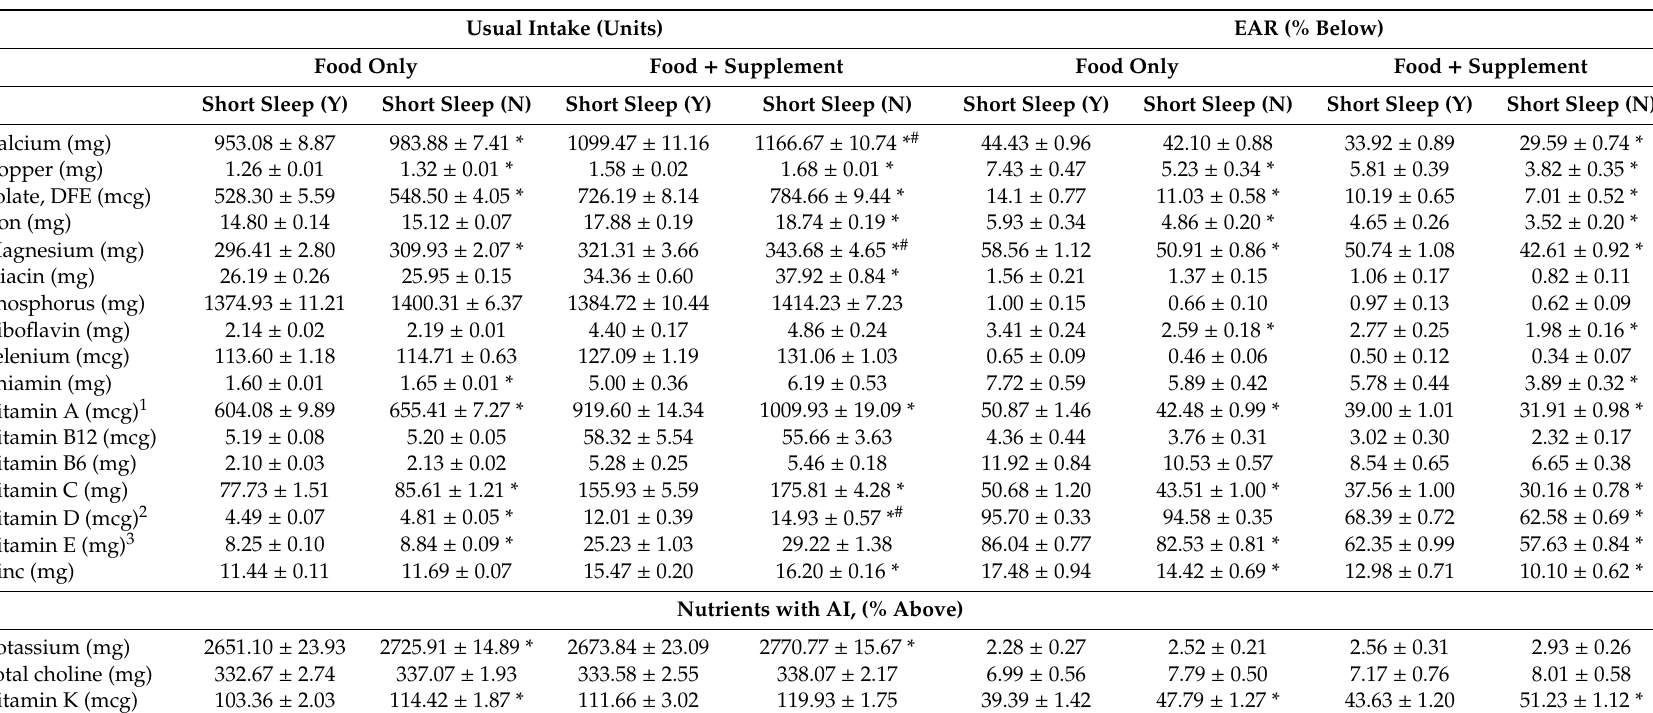
Table 2. Micronutrient usual intake (UI) (Food Only and Food + Spp) and inadequacy (% below estimated average requirement (EAR)) with and without short sleep duration in all